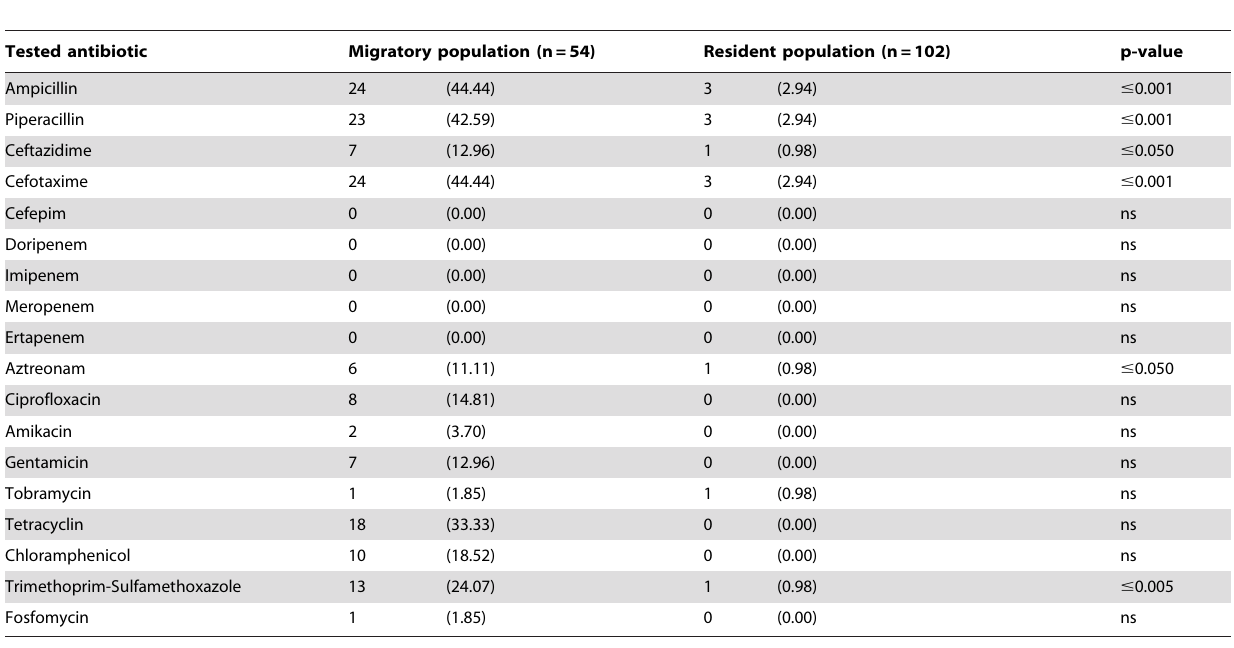
Table 3. Differences in the occurrence of antibiotic resistance between the migratory population (lob) and a the resistant population (wul) of